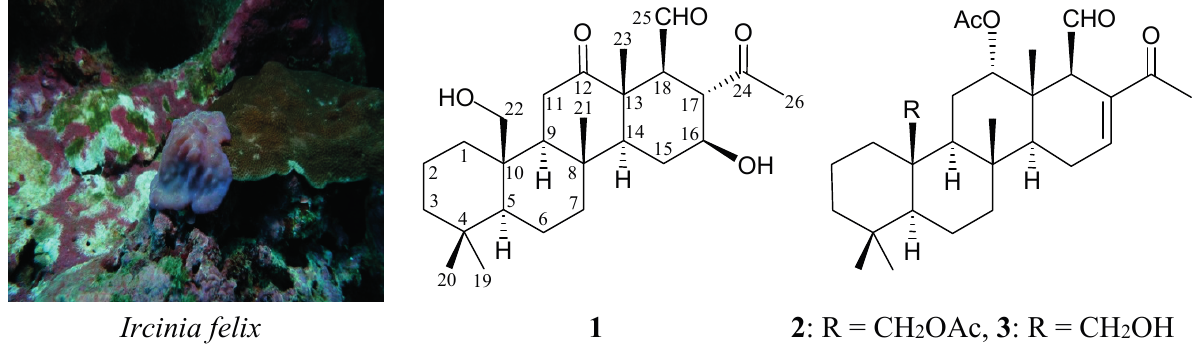
Figure 1. The sponge Ircinia felix and the structures of felixins F ( 1 ), G ( 2 ) and 12 α -acetoxy-22-hydroxy-24-methyl-24-oxoscalar-16-en-25-al ( 3